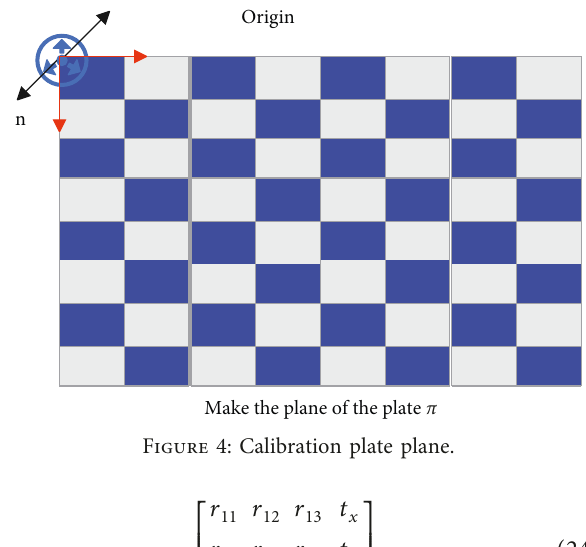
Figure 5: Correspondence in the camera coordinate system.